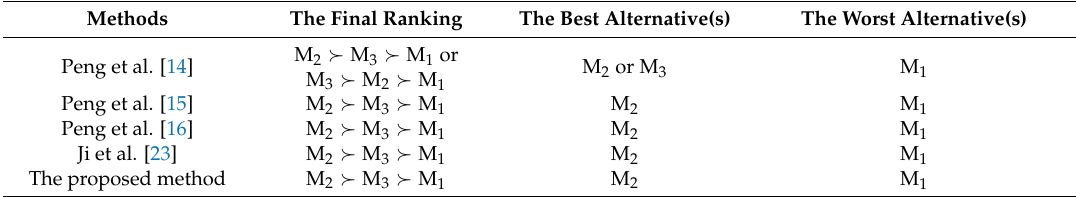
Table 6. The comparison results.